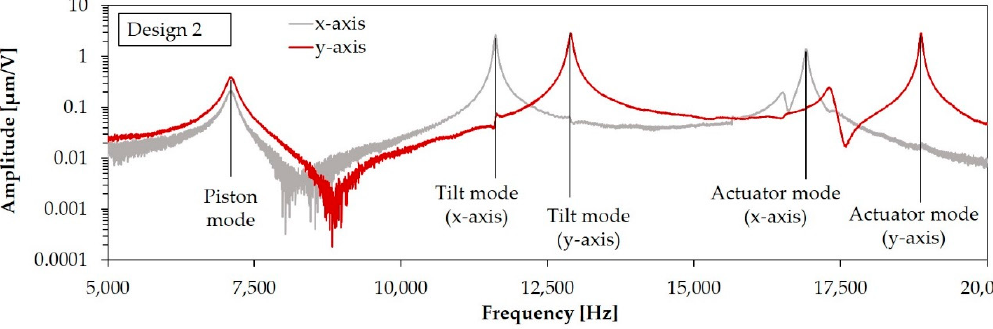
Figure 19. Frequency response curve of an individual sample of Design 2 for x- and y-axis (recorded at Point 1 and 2, respectively).